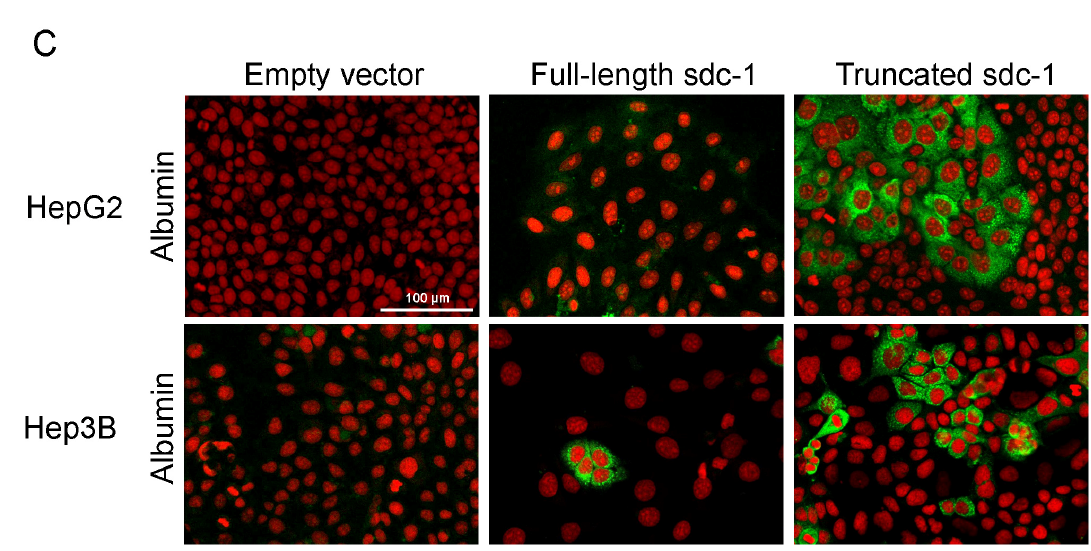
Figure 2. Hepatocyte-like di ff erentiation of HepG2 and Hep3B cells upon overexpression of full-length or truncated syndecan-1. ( A ) H&E stained empty vector transfected control cells were oval or spindle shape with prominent nuclei and high nucleus-to-cytoplasm ratio, and featured frequent cell divisions. In the syndecan-1-transfected cell lines, the numbers of poorly di ff erentiated and dividing cells decreased, and groups of cells with a more hepatocyte-like morphology appeared. Cells showing signs of di ff erentiation were characterized by a lower nucleus-to-cytoplasm ratio; ( B ) As a sign of cell di ff erentiation, desmoplakin immunocytochemistry showed relocalization of the protein to the cell surface in syndecan-1-transfected cells. In the native hepatoma cell lines, desmoplakin mainly localized to the cytoplasm. Red, desmoplakin and blue, nuclei; ( C ) Numerous albumin-positive cells were detected among the truncated syndecan-1 transfectants. Green, albumin and red, nuclei. Representative images are at 1000 × magnification (scale bar 15 µ m), 600 × magnification (scale bar 30 µ m), and 200 × magnification (scale bar 100 µ